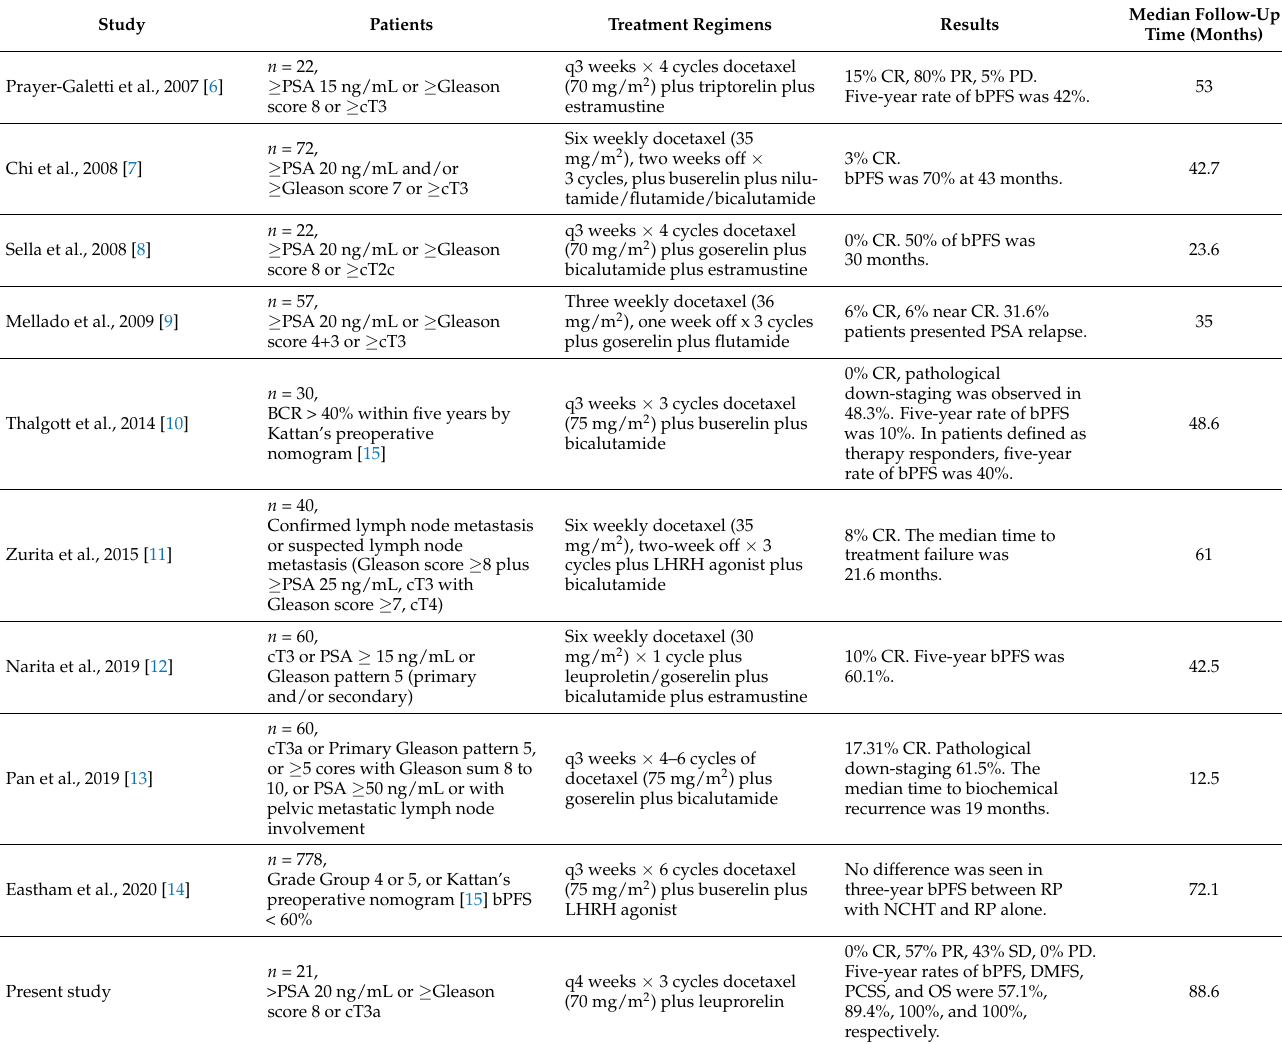
Table 4. Summary of neoadjuvant docetaxel-based chemohormonal studies before radical prostatecotomy.